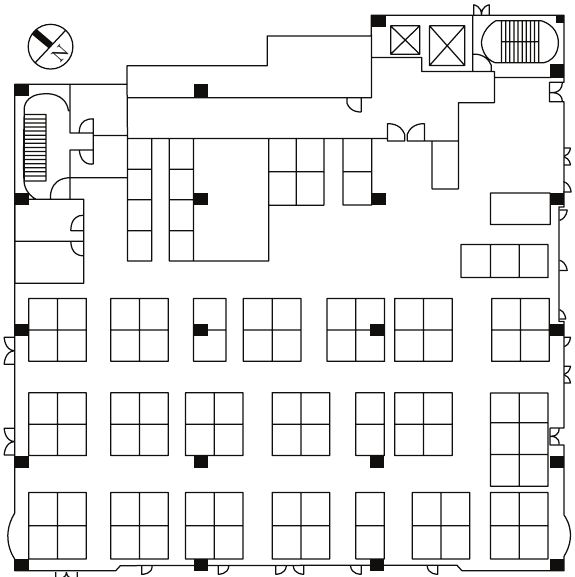
Figure 2: The floor plan of field test for this research.